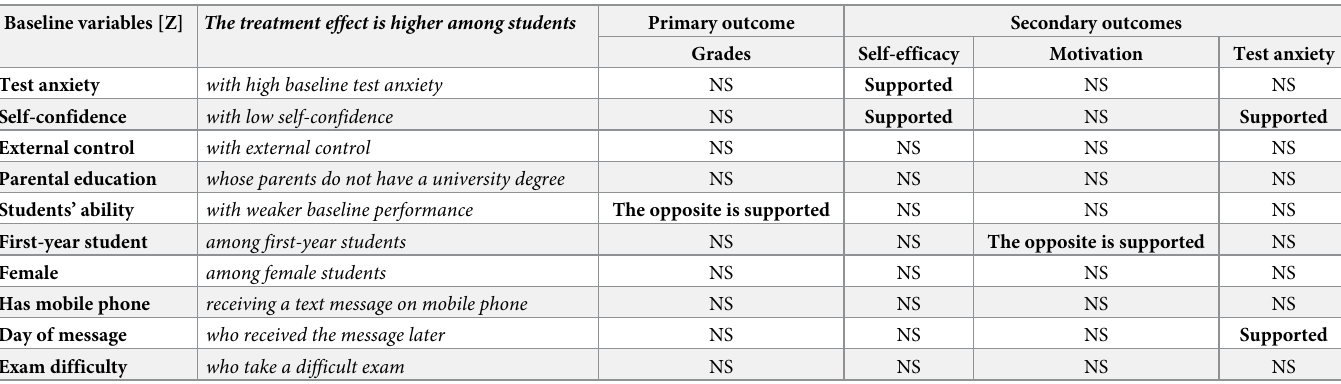
Table 6. Hypothesized treatment heterogeneity.